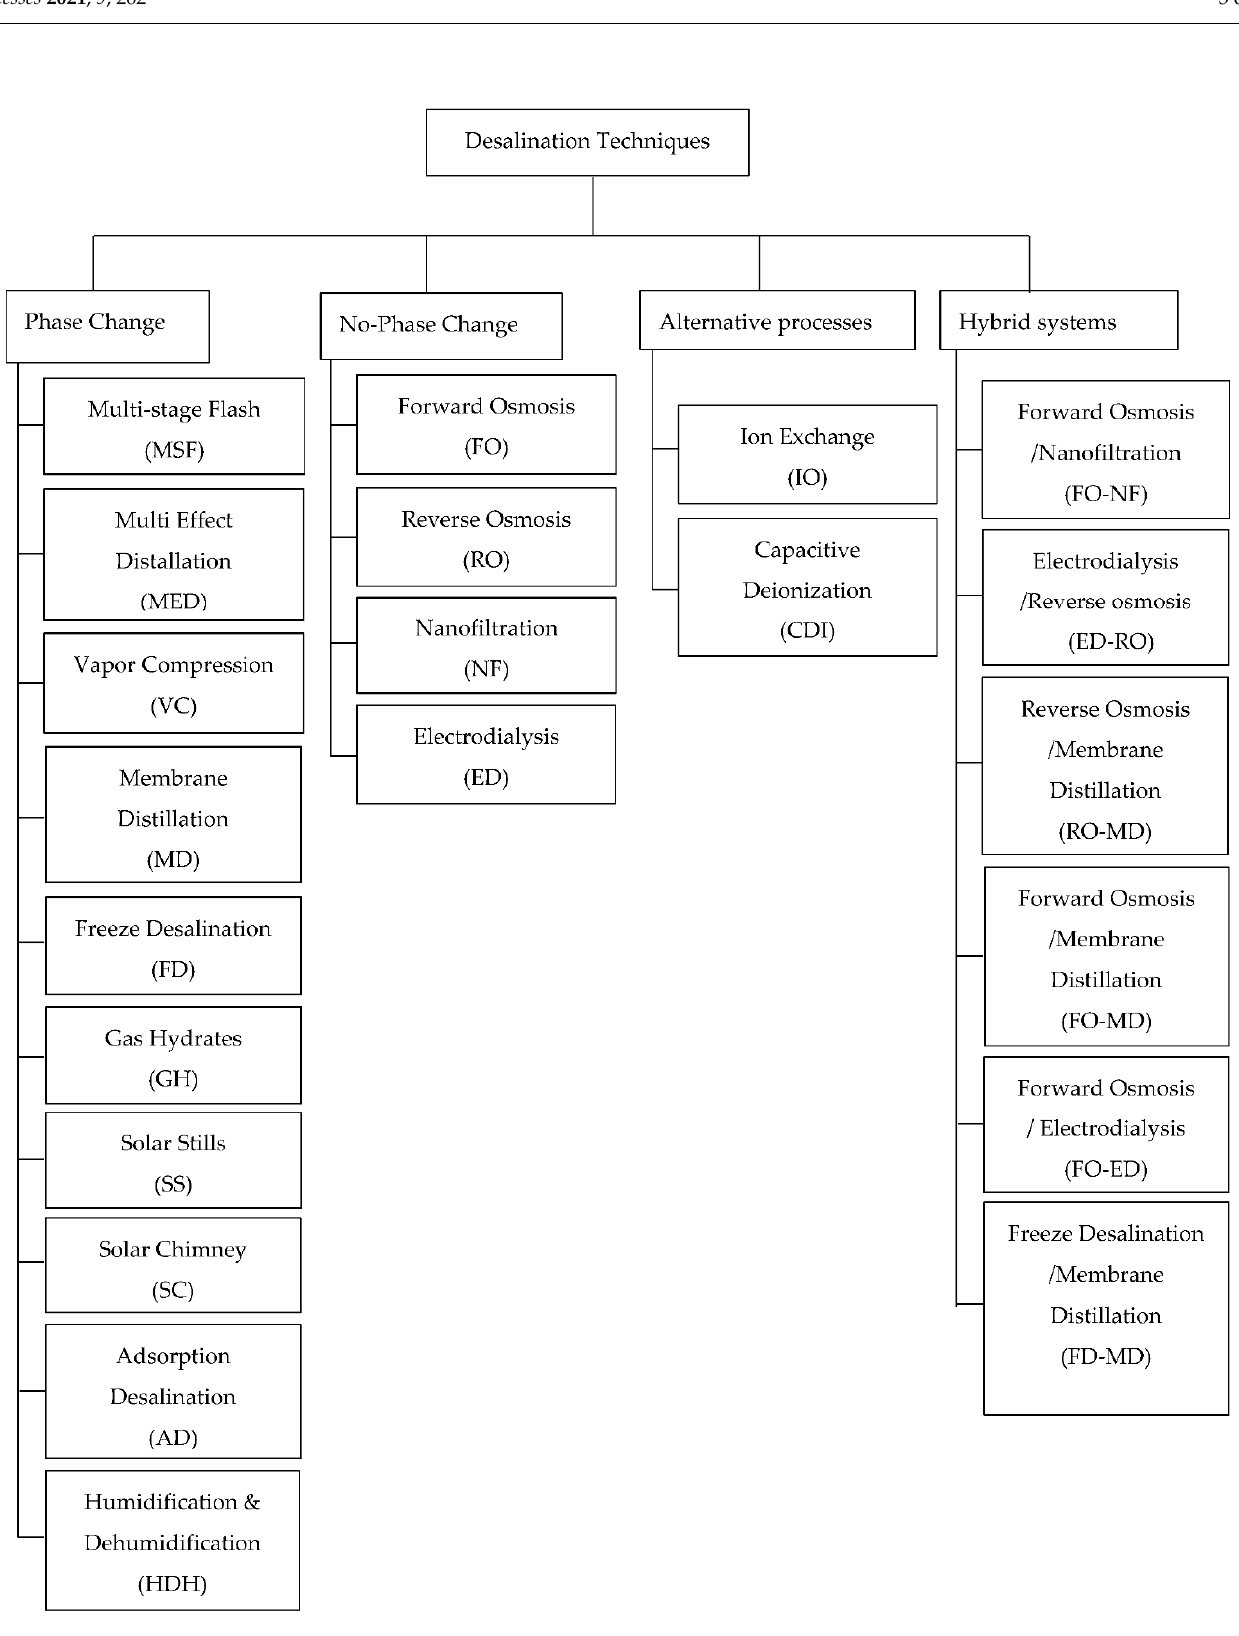
Figure 1. Available desalination technologies. Source: Adapted from Refs. [4,17,19,24].